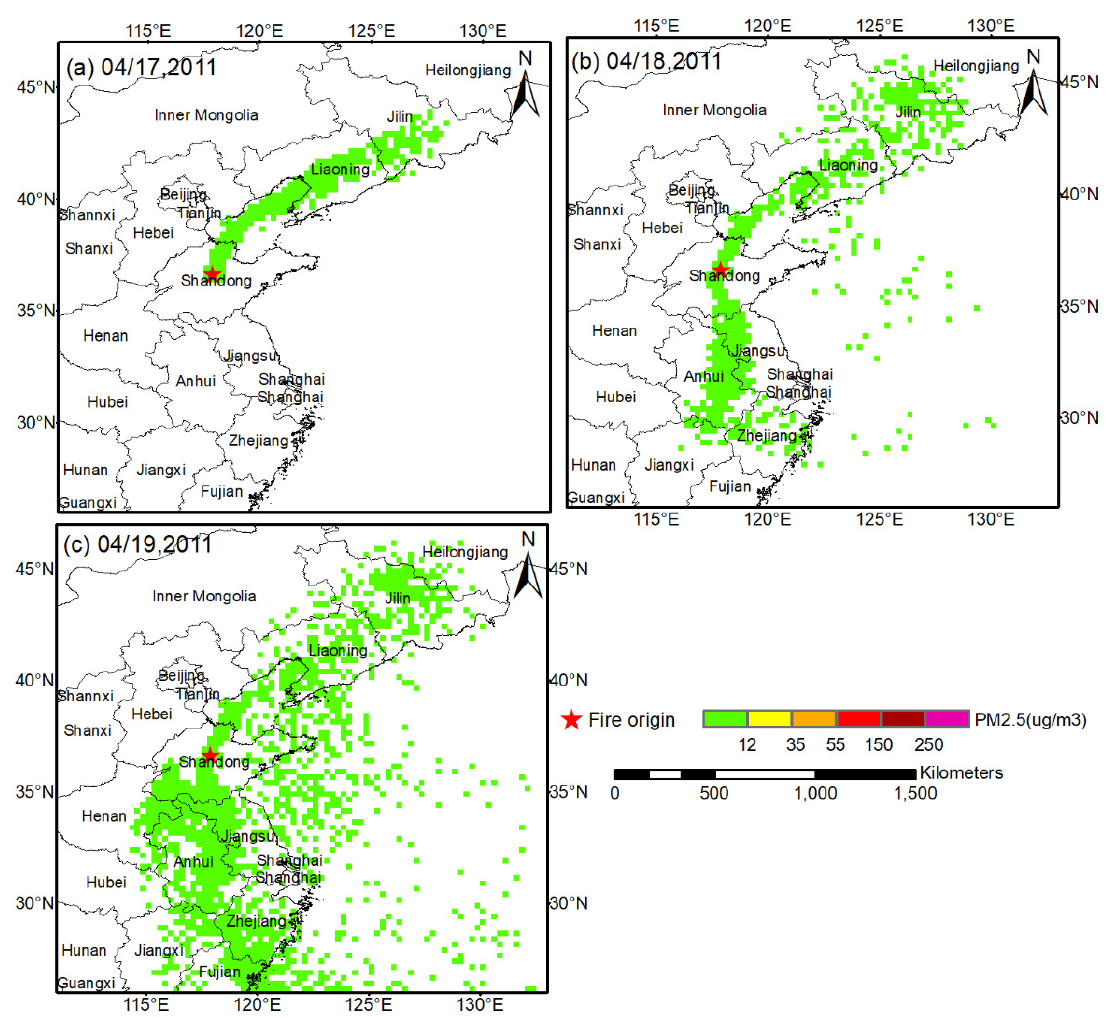
Figure A6. Same as Figure A1 except for the Laiwu fire. Panels ( a – c ) are 17, 18, and 19 April 2011, respectively.